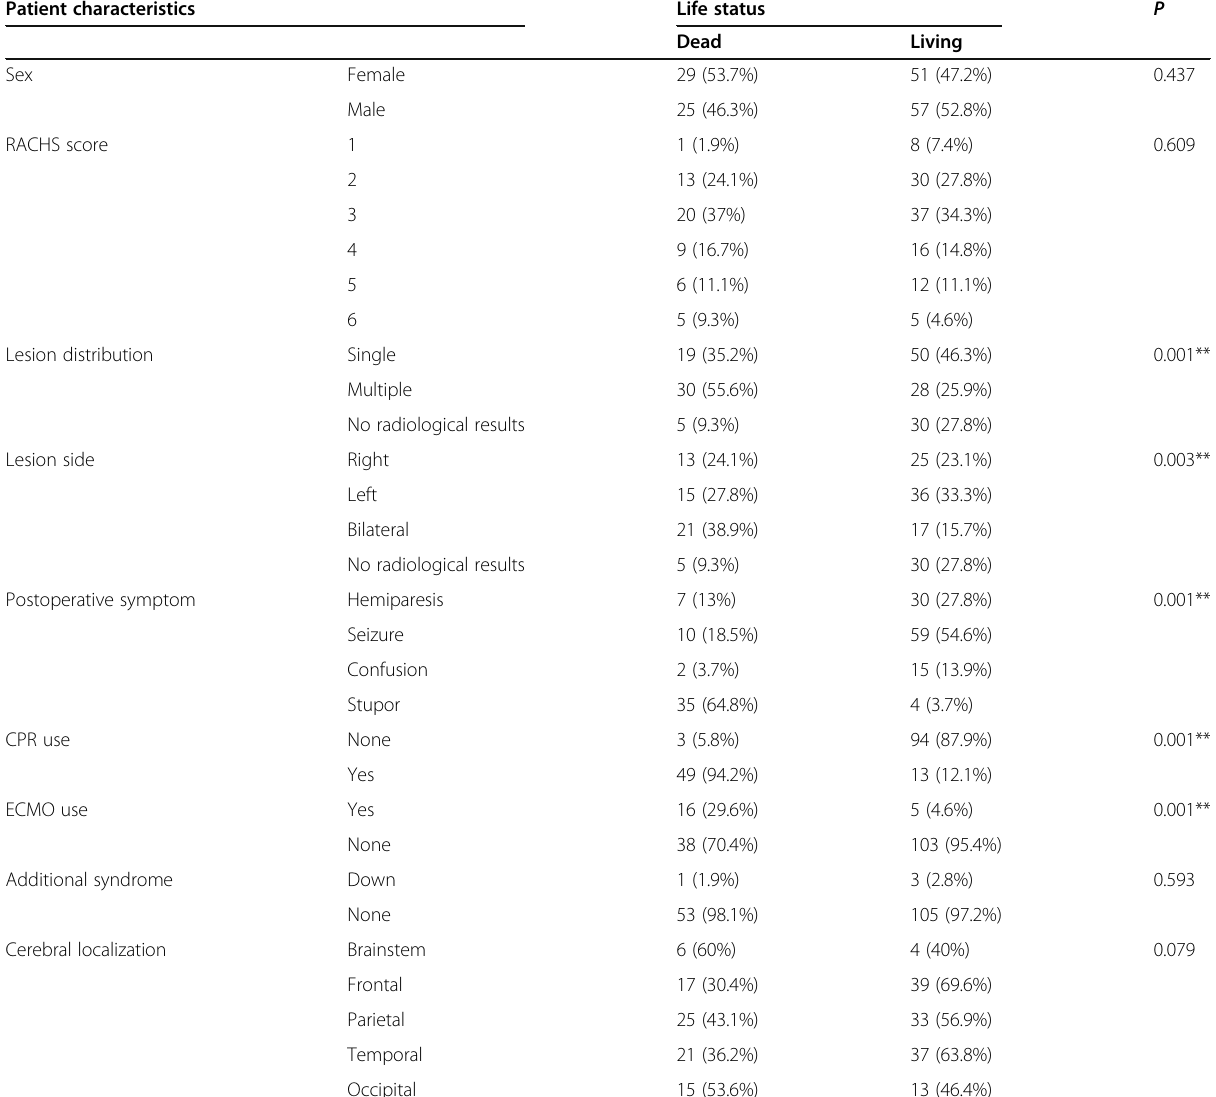
Table 2 The relationship between life status and measurements Patient